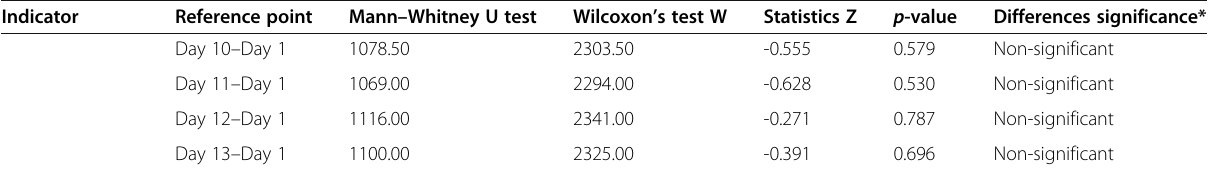
Table 5 Comparison of the symptoms dynamics in the observation groups according to the self-assessment (Mann-Whitney U test) (Continued)